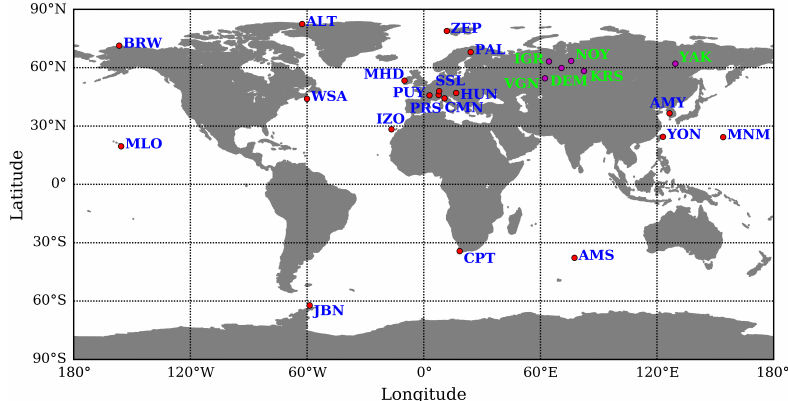
Figure 2. Map showing the location of the 19 WDCGG sites (red dots, blue labels) and six tower network sites in Siberia (magenta dots, green labels) for which we have performed comparison using forward GELCA simulation.